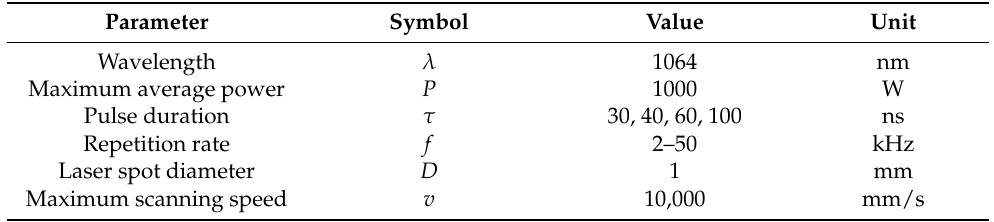
Figure 2. Schematic of laser-cleaning system and laser-cleaning scanning path. Table 1. Main parameters of the laser.